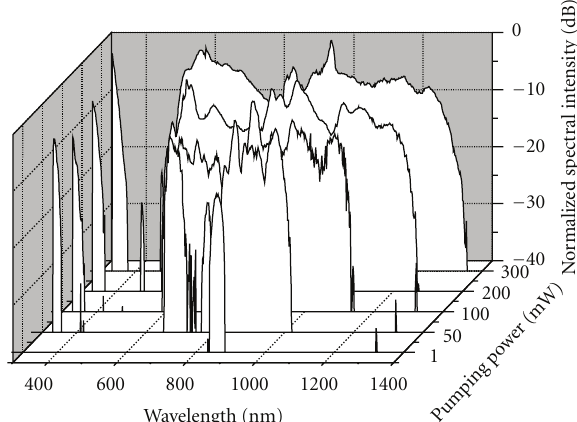
Figure 7: Experimental spectra for a 25-cm-long PCF versus wavelength at